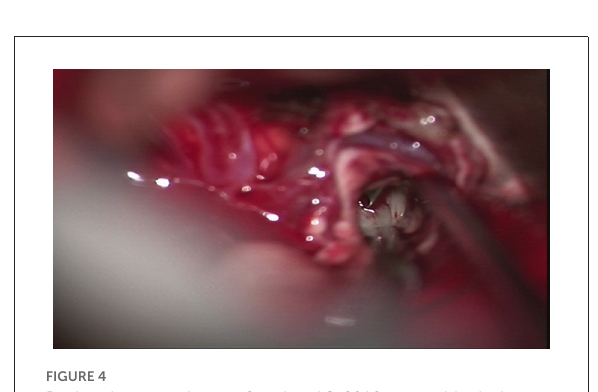
FIGURE4 During the operation on October 16, 2019, gray white lesions were